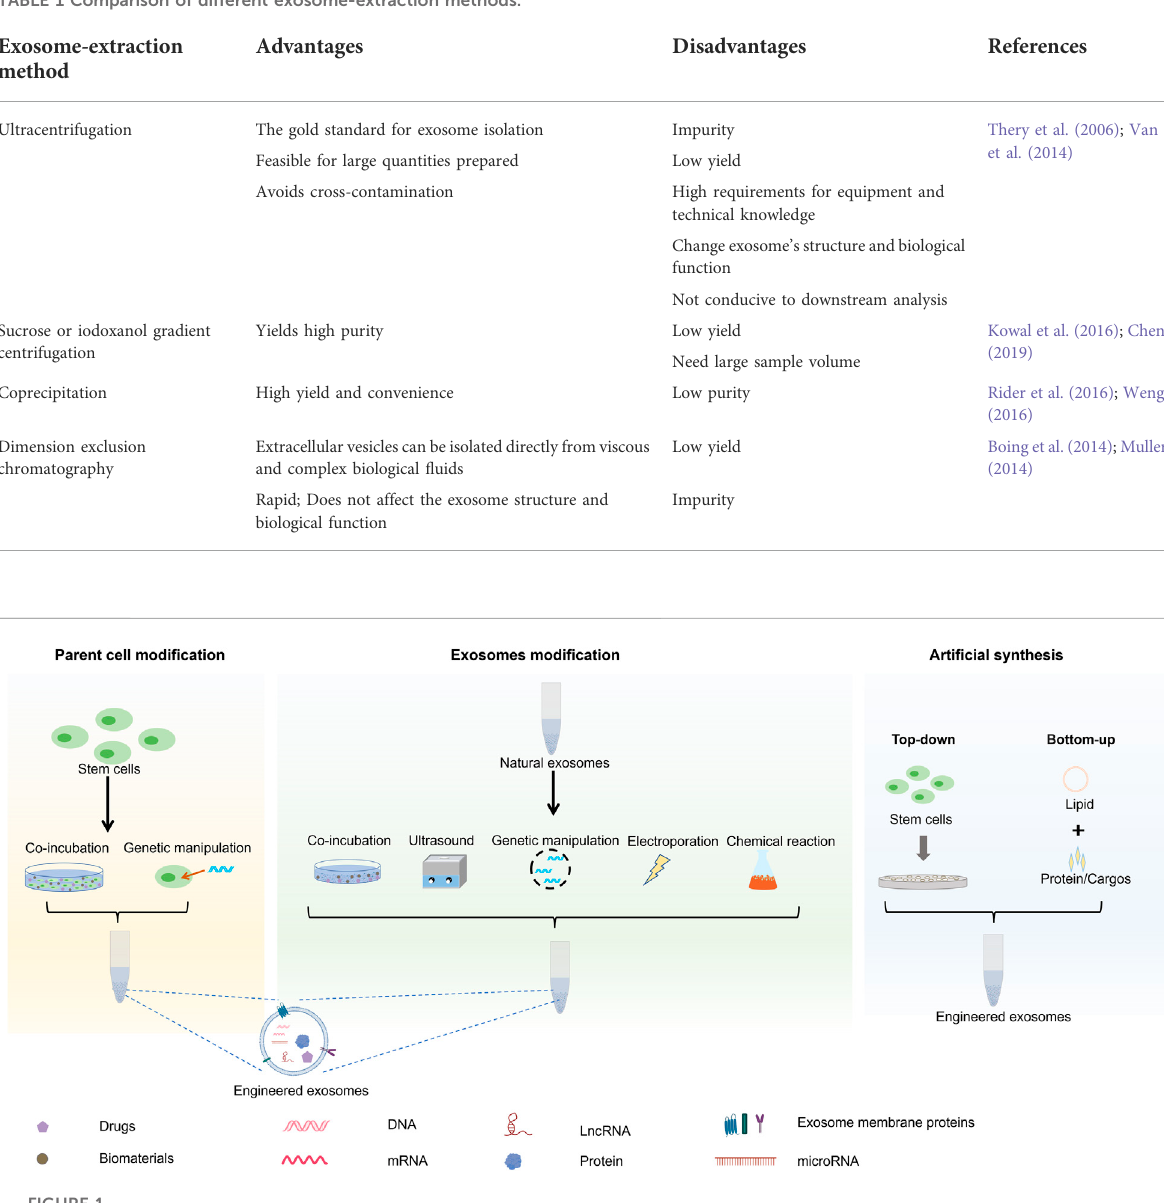
FIGURE 1 Illustration of the synthesis of engineered stem cell